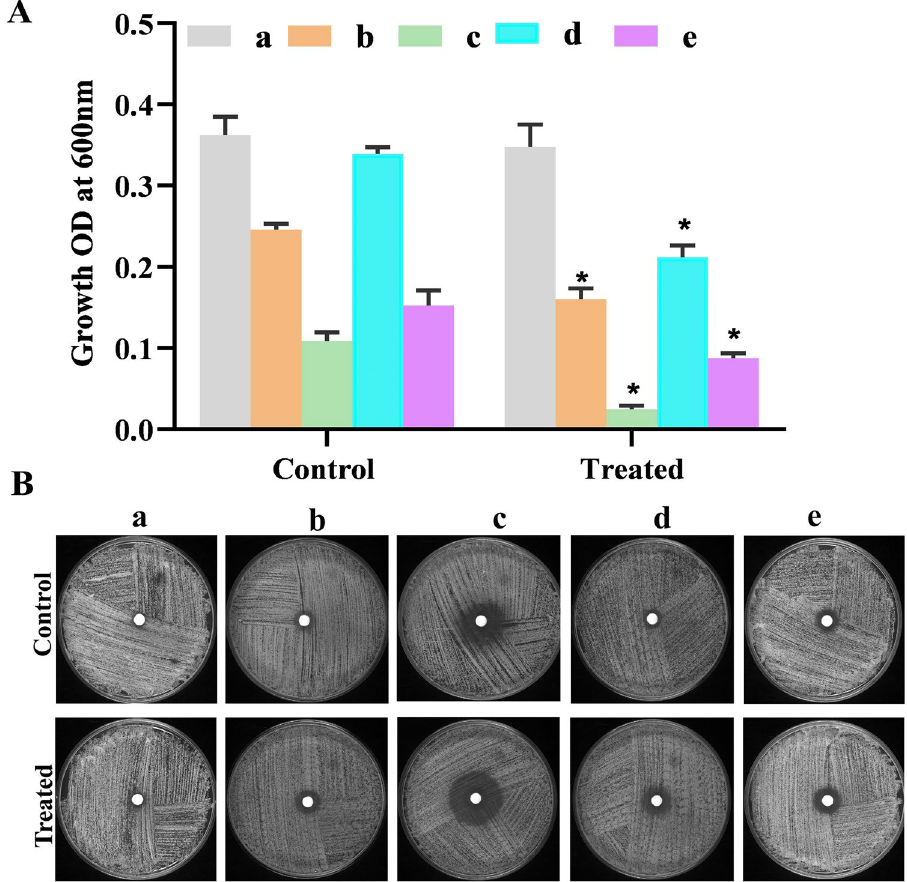
Figure 15. ( A ) Antifungal susceptibility testing of catechol pretreated (3 h) C. albicans cells after 24 h incubation using broth micro dilution assay. ( B ) Antifungal susceptibility testing of catechol pretreated C. albicans cells to conventional antifungals using disc diffusion method. (a) Flucanozole (b) micanozole (c) ketoconazole (d) nystain and (e) amphotericin-B. Error bars indicates the mean values of three experimental duplicates. The “* “and “**” symbols represents the statistical significance of p < 0.05 and p < 0.01,